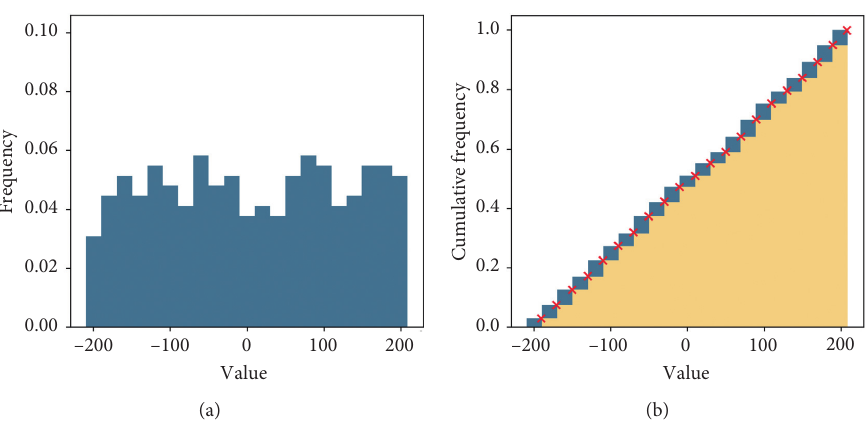
Figure 3: Illustration of training data generation. The x -axes of both histograms represent values in raw data. In the frequency distribution histogram (a), the y -axis represents the frequency of each interval. In the cumulative frequency distribution histogram (b), the y -axis represents the total frequency of the present interval (blue) and all intervals on the left (yellow).